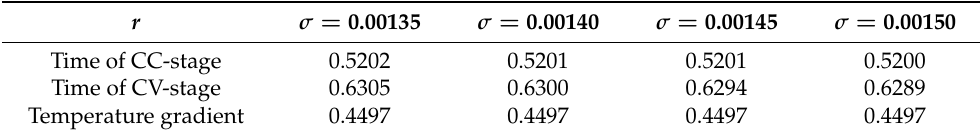
Table 6. Weight of different perturbation